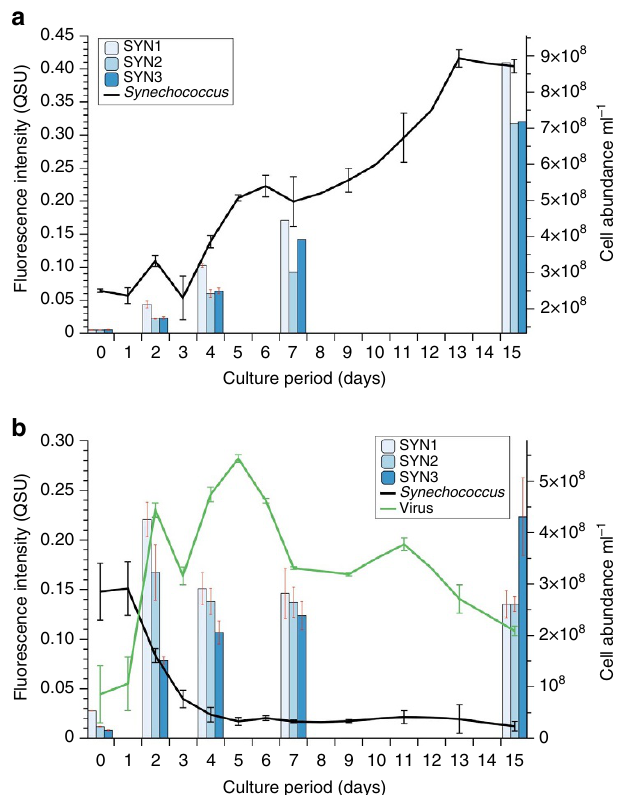
Figure 4 | Synechococcus growth experiment with and without viral- induced lysis. Fluorescence intensities (SYN1, SYN2 and SYN3) derived from the EEM-PARAFAC model of the cultured Synechococcus (CB0101) without ( a ) and with ( b ) virus during a 15 days’ growth experiment. Error bars are expressed as